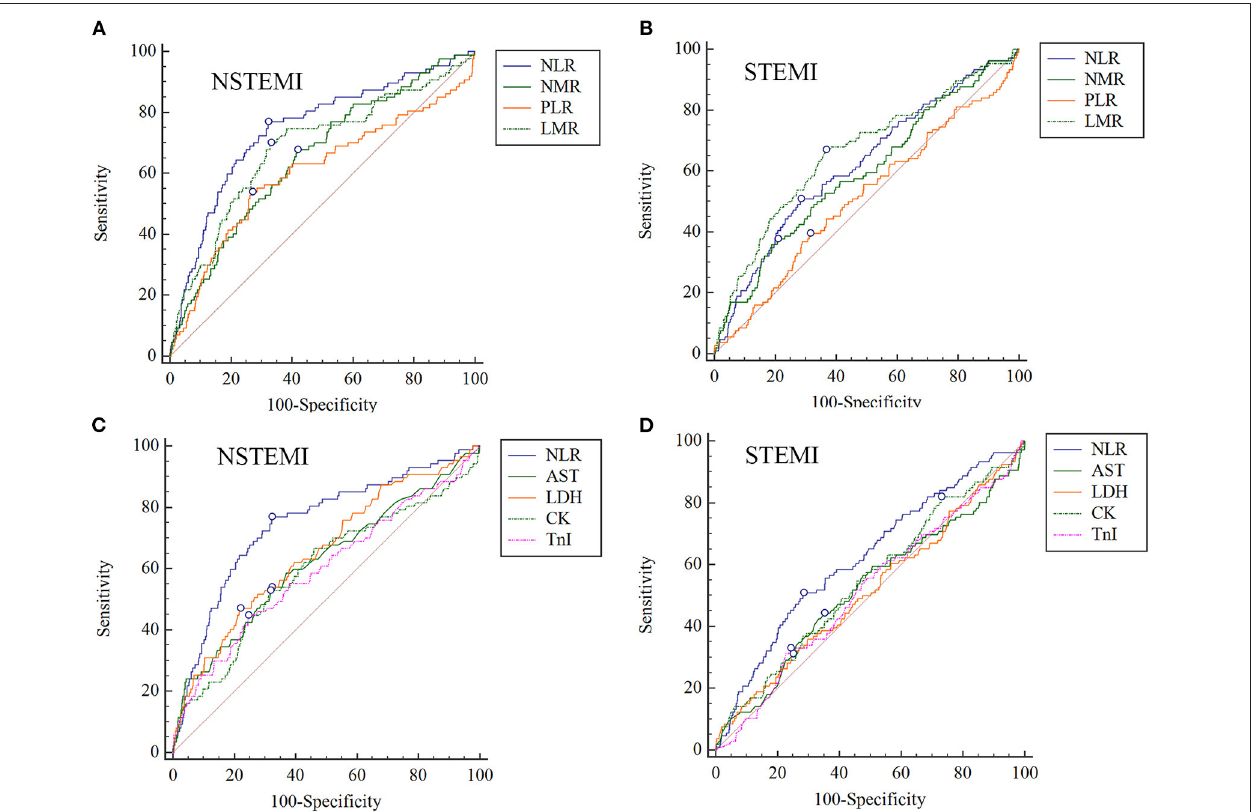
FIGURE 1 | Comparison of ROC curves of common ratios and biomarkers in NSTEMI and STEMI groups, respectively. (A,B) Comparison of NLR, NMR, PLR, and LMR in predicting in-hospital death in NSTEMI and STEMI groups, respectively. (C,D) Comparison of NLR, AST, LDH, CK, and TnI in NSTEMI and STEMI groups, respectively. NLR, neutrophil-to-lymphocyte ratio; NMR, neutrophil-monocyte ratio; PLR, platelet-lymphocyte ratio; LMR, lymphocyte-monocyte ratio; AST, aspartate aminotransferase; LDH, lactate dehydrogenase; CK, creatine